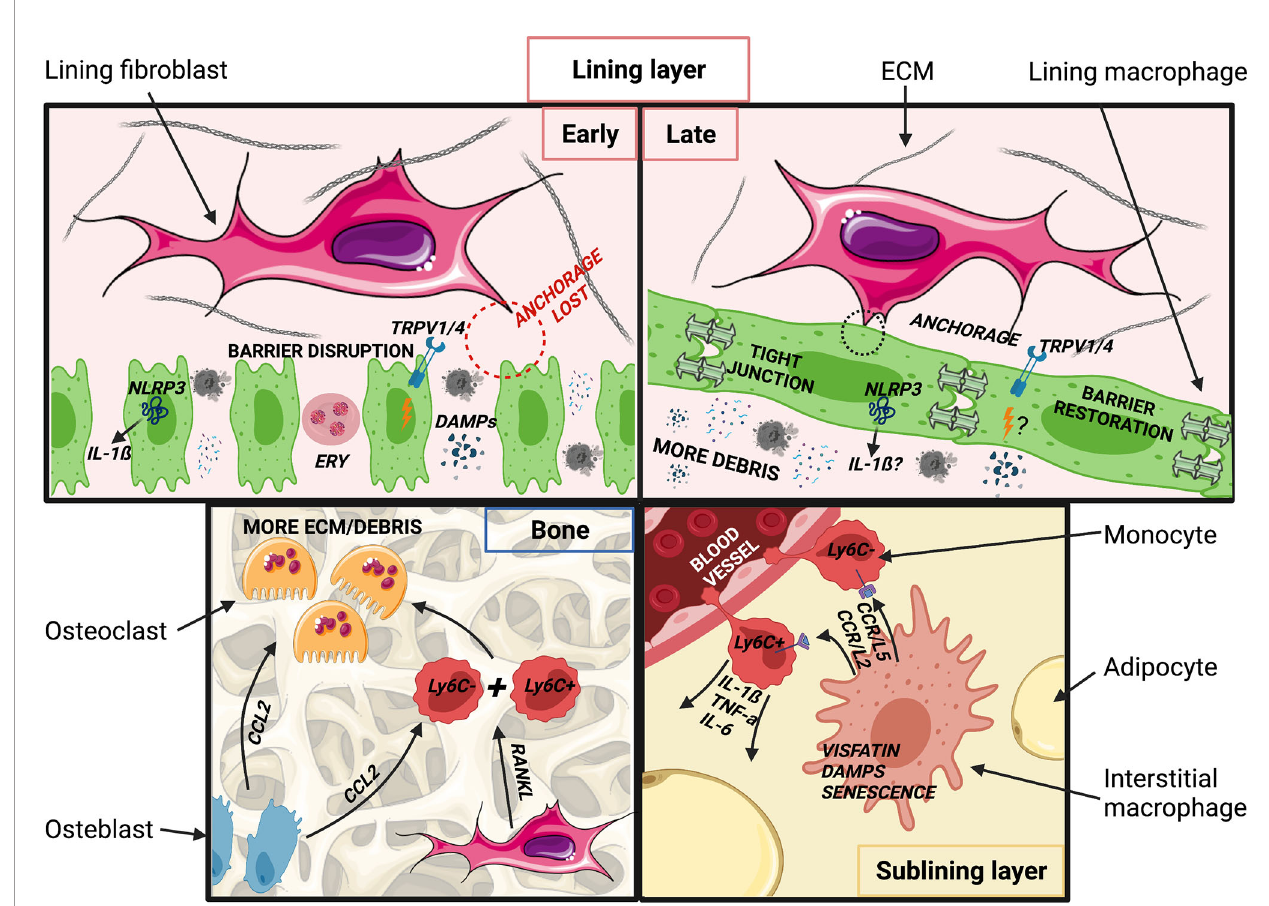
FIGURE 3 | Putative changes in joint tissues after injury and during post-traumatic OA development. (Top, left) Acutely following injury, synovial lining macrophages are spatially re-orientated and the barrier is disrupted. DAMPs, PAMPs and catabolic enzymes are released into the synovial cavity by chondrocytes and damaged tissues (ligament, meniscus). Extra-vascular erythrocytes and associated free heme from blood vessel injury may pathologically imprint synovial macrophages. Barrier disruption may impede cyclic stretching of lining macrophages, resulting in NLRP3 in fl ammasome activation and increased IL-1ß production, known to promote of OA. Altered mechanics may also promote joint in fl ammation through TRPV1/4 cation channels. (Top right) At later stages of ptOA pathogenesis, the synovial lining layer may be restored. Levels of IL-1ß remain elevated, though involvement of the NLRP3 in fl ammasome is unclear. TRPV1 activation may continue to promote OA pathogenesis, although likely via signals other than or in addition to mechanical stimuli. Cellular debris, DAMPs and PAMPs remain abundant in the synovial cavity and thus potentially imprint pathological macrophage phenotypes. (Bottom, left) Increased numbers and activation of osteoclasts contribute to accelerated bone turnover and remodeling in the arthritic joint. Osteoclastogenesis may be promoted by CCL2 produced by activated osteoblasts and in fl ammatory cells, potentially resulting in recruitment and fusion of Ly6C high and Ly6C low monocytes, a process that may be further stimulated by RANKL produced by lining fi broblasts. (Bottom, right) In the sublining layer, exposure to ECM degradation products may stimulate interstitial macrophages to produce CCL2 and CCL5, leading to recruitment of Ly6C high and Ly6C low monocytes. Ly6C high monocytes produce IL-1ß, TNF- a and IL-6, potentially in response to the adipokine visfatin, a TLR4 receptor agonist, which also induces changes in the subchondral bone. Ly6C low monocytes may supply the interstitial macrophage pool, but these macrophages may retain higher baseline NF- k B and IL-1ß activity than those in healthy joints. Created with BioRender.com and